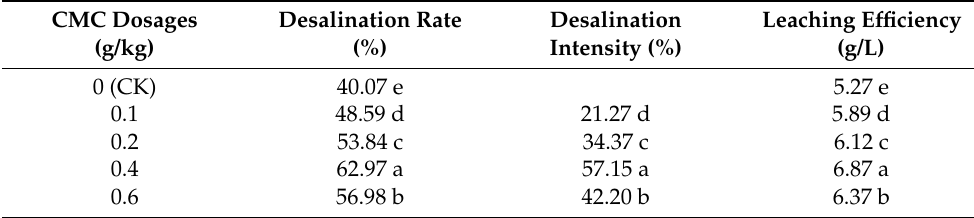
Table 3. Effect of CMC dosage on soil salt